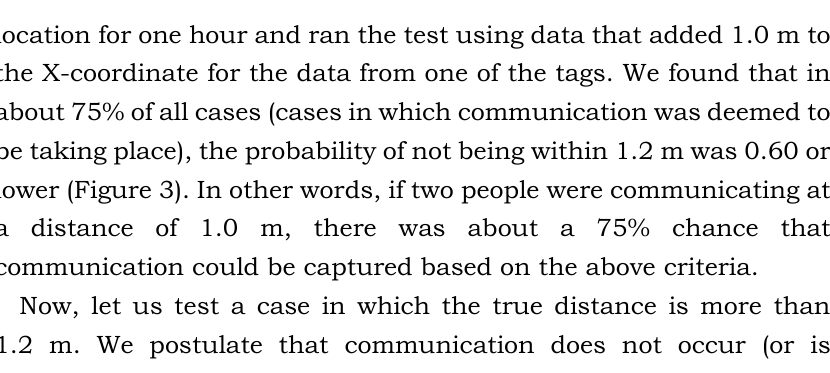
Figure 3. The case when the true distance is 1.0